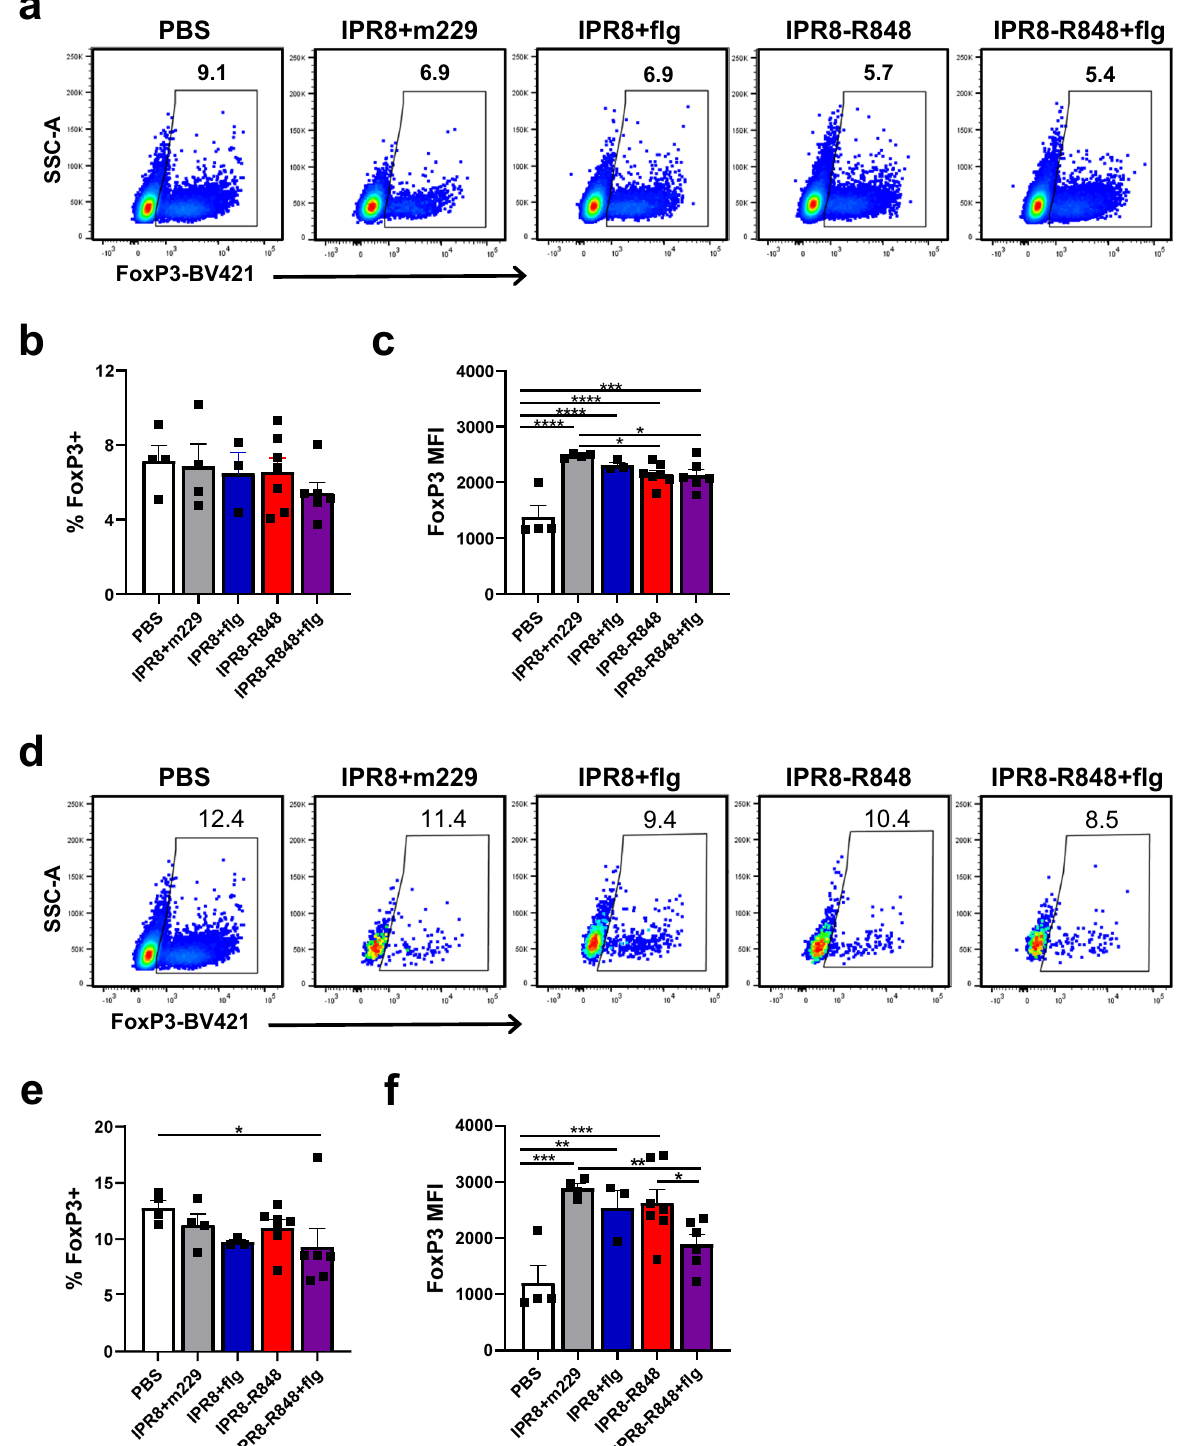
Fig. 6 Vaccination in the presence of TLRa adjuvants alters Tregs in peripheral blood 10 days after vaccine boost. Tregs were quanti fi ed by intracellular staining for FoxP3 in peripheral blood collected from newborns at d10 p.b. or age matched naïve controls. a Representative data of FoxP3 + expression in live CD3 + CD4 + PBMC. b Average percent of live CD3 + CD4 + cells expressing FoxP3 in circulation. c Average median fl uorescent intensity of FoxP3 within the CD3 + CD4 + FoxP3 + population. To assess the representation of Tfr within the T follicular subset, FoxP3 + cells were quanti fi ed within the CD3 + CD4 + CXCR5 + ICOS + population described in Fig. 4b; representative data are shown in d and average frequencies in e . f Average median fl uorescent intensity of FoxP3 in the CD3 + CD4 + CXCR5 + ICOS + FoxP3 + Tfr population. Statistical signi fi cance was determined by ordinary one-way ANOVA with uncorrected Fisher ’ s LSD test for multiple comparisons. * p < 0.05, ** p < 0.01, *** p < 0.001, **** p <